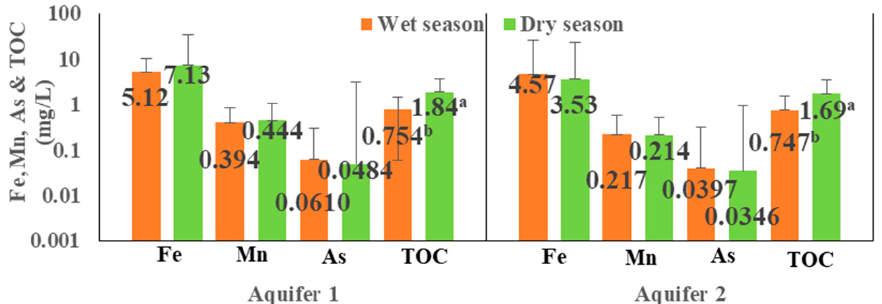
Figure 4. The mean concentrations of Fe, Mn, As, and TOC in addition to statistical results in Aquifer 1 and Aquifer 2 between the wet and dry seasons. (a superscript character after the mean value means that the water quality parameter has significant differences).